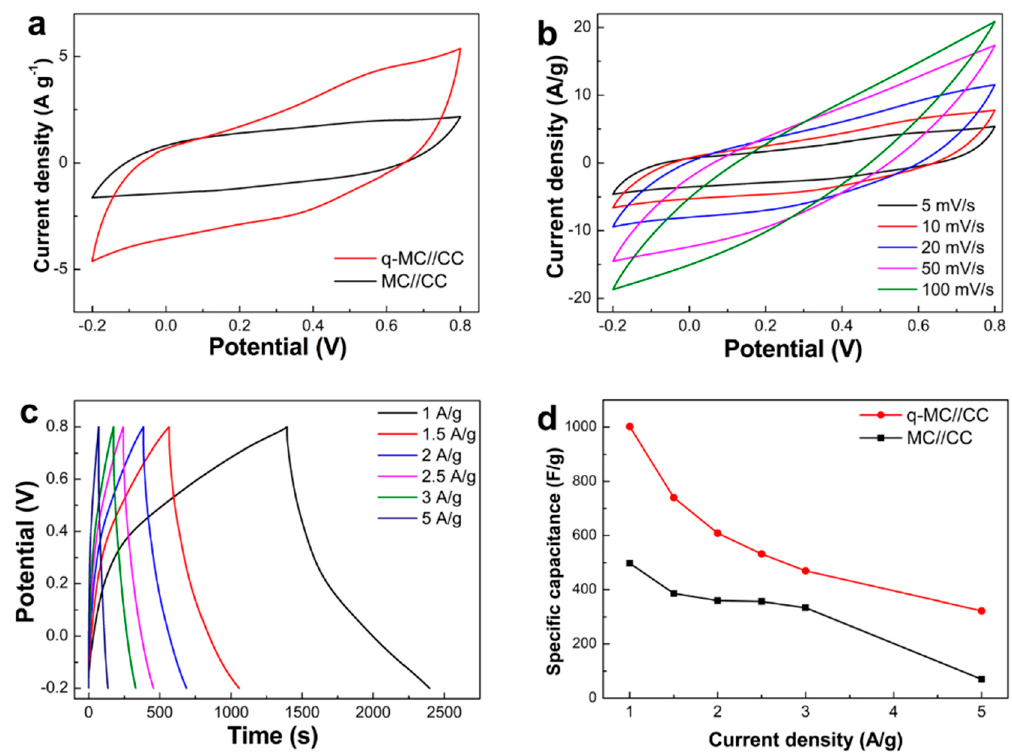
Figure 4. ( a ) Cyclic voltammetry (CV) curves of q-MC // CC and MC // CC. ( b ) CV curves of q-MC // CC at di ff erent scan rates. ( c ) Galvanostatic charge–discharge curves of q-MC // CC at di ff erent current densities. ( d ) Gavimetric specific capacitance of q-MC // CC at di ff erent current densities.